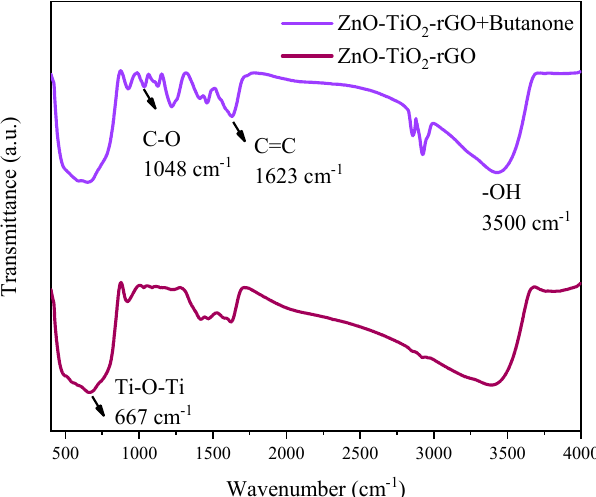
Figure 7. Infrared spectra of ZnO-TiO 2 -rGO before and after the passage of butanone vapor.